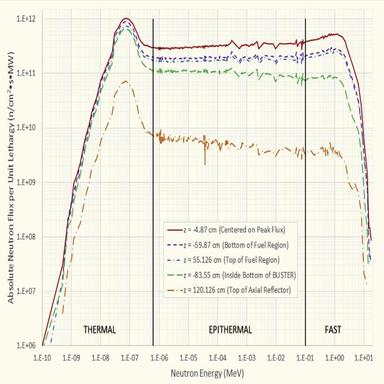
Absolute Neutron Flux per Unit Lethargy Axial Spectral Distribution for Full-Slotted Core (300 K).